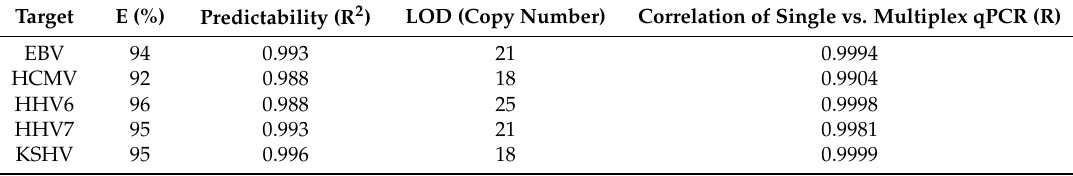
Table 2. Efficiency, predictability and limit of detection of the multiplex standard curves and correlation of single vs. multiplex qPCR.